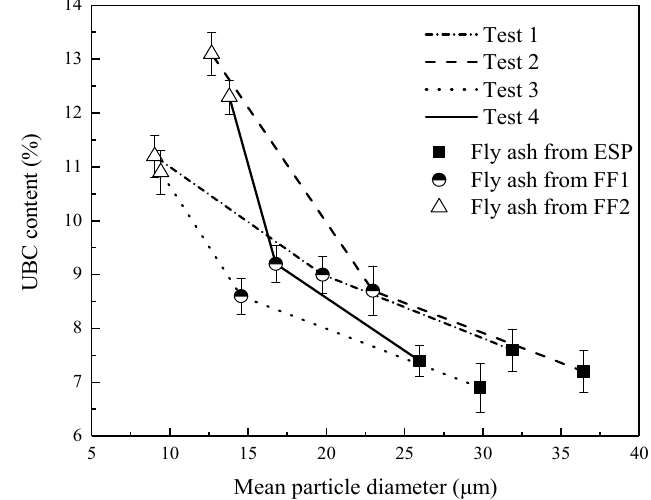
Figure 10. Mean particle diameter of the fly ash samples collected from the ESP, FF1 and FF2.